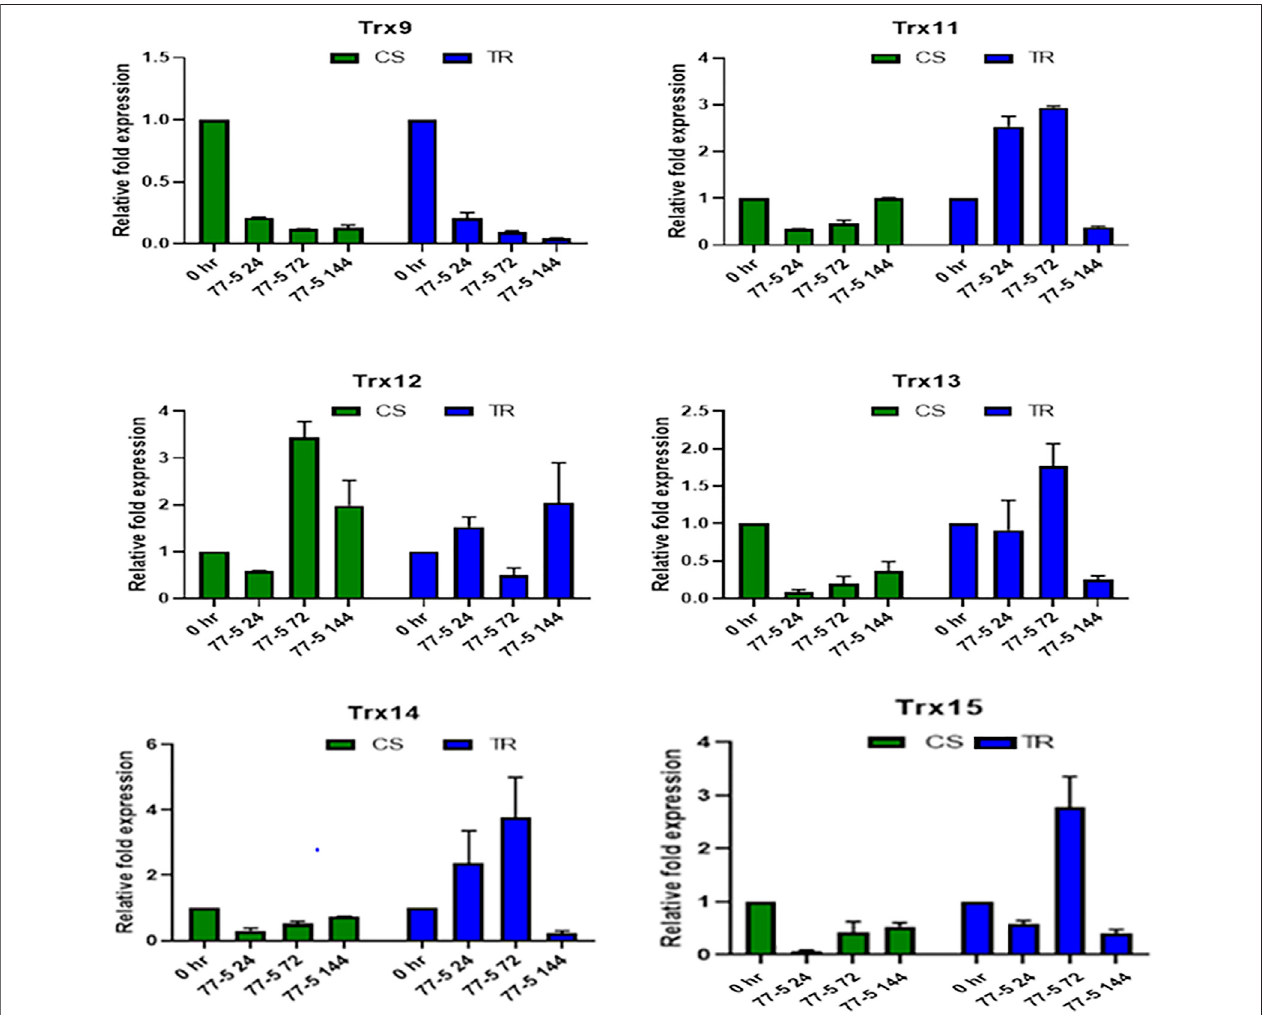
FIGURE 7 | Expression analysis of Trx family genes (Trx 9, Trx 11, Trx 12, Trx 13, Trx 14, and Trx 15) in response to leaf rust inoculation. Chinese spring (CS) and Introgression line of leaf rust resistance gene (Lr9) in CS, Transfer (TR). Leaf rust pathogen Puccinia triticina Eriks Pathotype 77-5 (112-R-63) uredospores were inoculated on 10 days old wheat seedlings and kept in a humidity chamber for 24 h. Leaf samples for qRT-PCR analysis were collected at 0 hafter inoculation HAI, 24 HAI, 72 HAI, and 144 HAI. Values are mean (±SE) of three biological replicates.